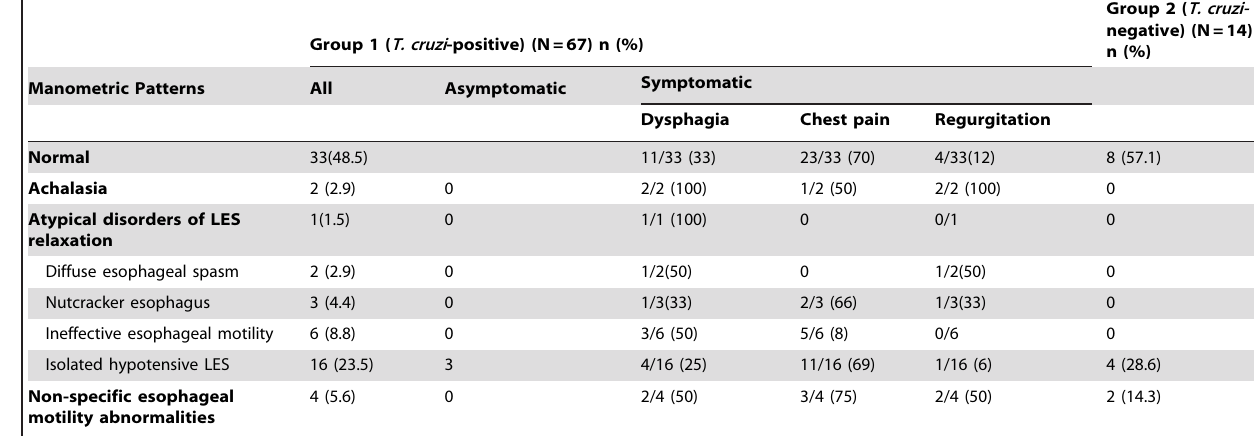
Table 4. Manometric patterns and association with